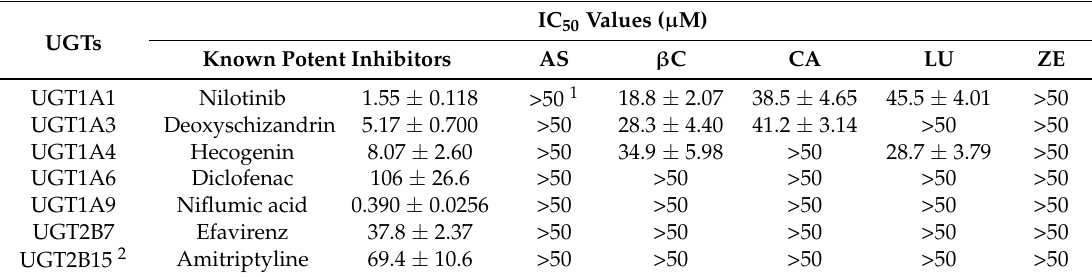
Figure 1. IC 50 curves of β -cryptoxanthin for human UGTs activities including UGT1A1 for β -estradiol- 3-glucuronidation ( A ); UGT1A3 for chenodeoxycholic acid 24-acyl- β - D -glucuronidation ( B ); UGT1A4 for trifluoperazine- N -glucuronidation ( C ); UGT1A6 for serotonin- O -glucuronidation ( D ); UGT1A9 for propofol- O -glucuronidation ( E ); and UGT2B7 for zidovudine-5 ′ -glucuronidation ( F ) in human liver microsomes, and UGT2B15 for 4-methylumbelliferyl glucuronidation ( G ) in recombinant human UGT2B15 supersomes. Data are the mean ± standard deviation of triplicate determinations. The dashed lines represent the best fit to the data using non-linear regression. Table 1. IC 50 values of known potent UGTs inhibitors and AS, β C, CA, LU and ZE towards the seven UGTs isoforms. IC 50 Values ( µ M) UGTs Known Potent Inhibitors AS β C CA LU